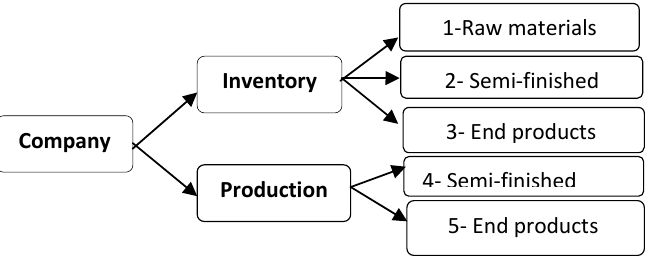
Fig. 1. Five parts production management